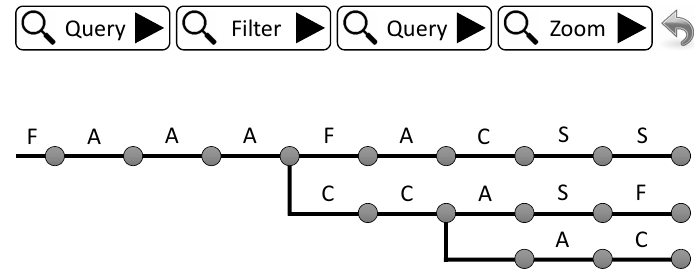
Figure 3: Two illustrations of typical visual overviews of stored states. The linear structure in the upper row is inspired by the action trail of HARVEST and the tree structure in the bottom row is inspired by the history tree of